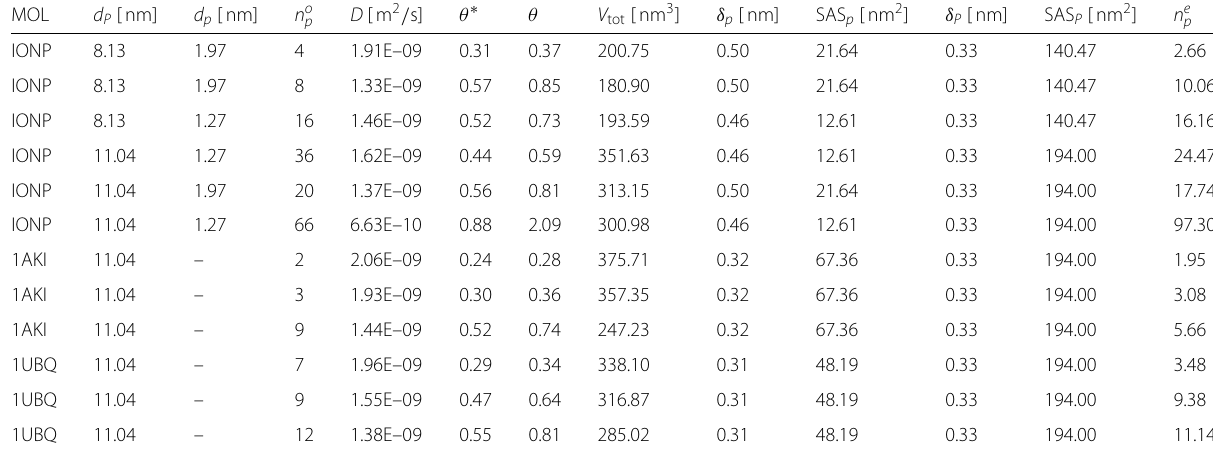
Data for the iron-oxide nanoparticles (IONP) have been taken from the supplementary information in [24], while those for proteins (1AKI and 1UBQ) have been computed for the present work. Notice that Eq. (1) has been applied considering D C = 0.39 × 10 − 9 m 2 / s. n e p is the number of particles estimated using the proposed protocol; n o p the original (actual) number of particles in the simulated setups suggested nano-metering protocol with respect to the characteristic filling time of the nanopores.